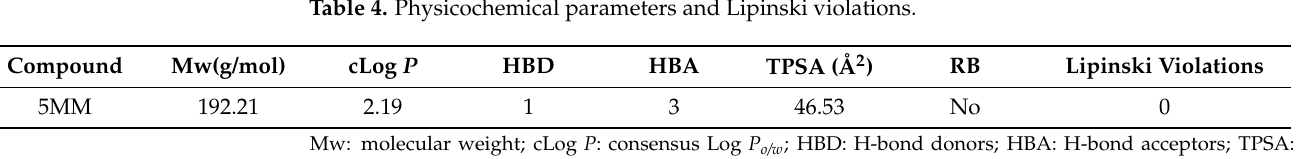
Table 4. Physicochemical parameters and Lipinski violations.